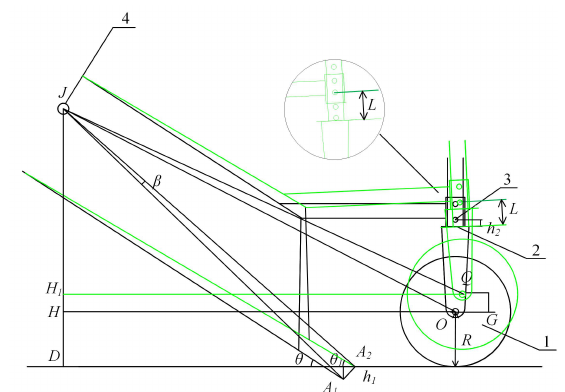
Figure 4. Schematic diagram of operation parameter adjustment of pickup. 1. Profiling wheel. 2. Fixing plate. 3. Profiling rod hole. 4. Pickup device drive